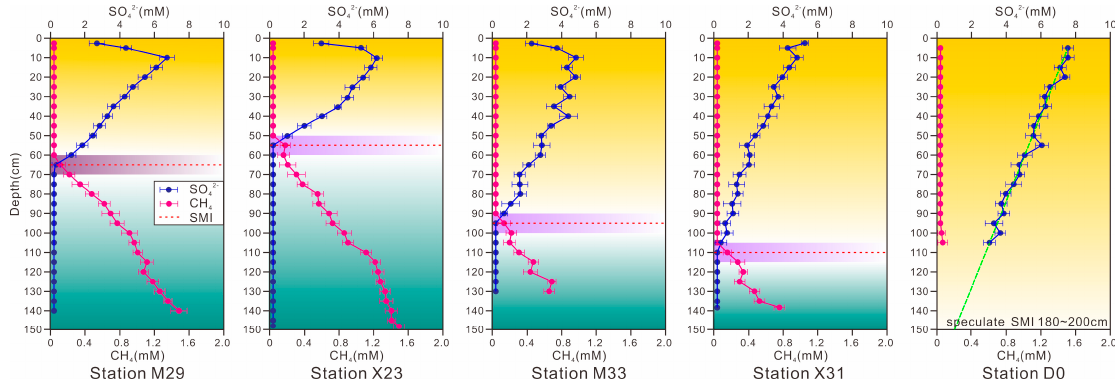
Figure 2. Concentration profiles of sulfate and methane in pore